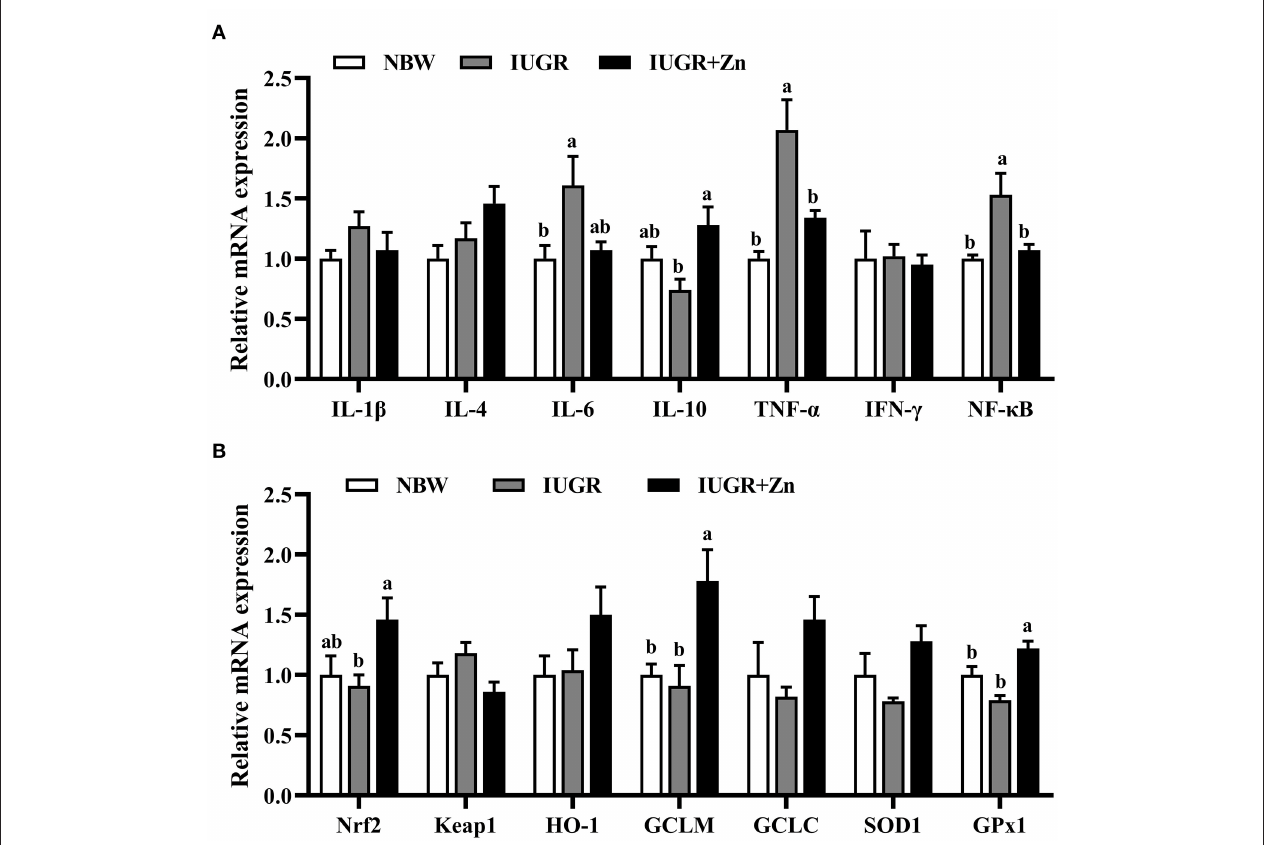
FIGURE 3 | Effects of dietary Nano-ZnO supplementation on the mRNA expressions in jejunal mucosa of finishing pigs. (A) Inflammation related mRNA expression. (B) Antioxidant related mRNA expression. Data are normalized to the NBW group and expressed as means with their SEM ( n = 6). a,b Means for the same parameter with different superscripts are significantly different ( P < 0.05). IL-1 β , interleukin-1 β ; IL-4, interleukin-4; IL-6, interleukin-6; IL-10, interleukin-10; TNF- α , tumor necrosis factor- α ; IFN- γ , interferon- γ ; NF- κ B, nuclear factor kappa-B; Nrf2, nuclear respiratory factor 2; GCLC, glutamate-cysteine ligase catalytic subunit;